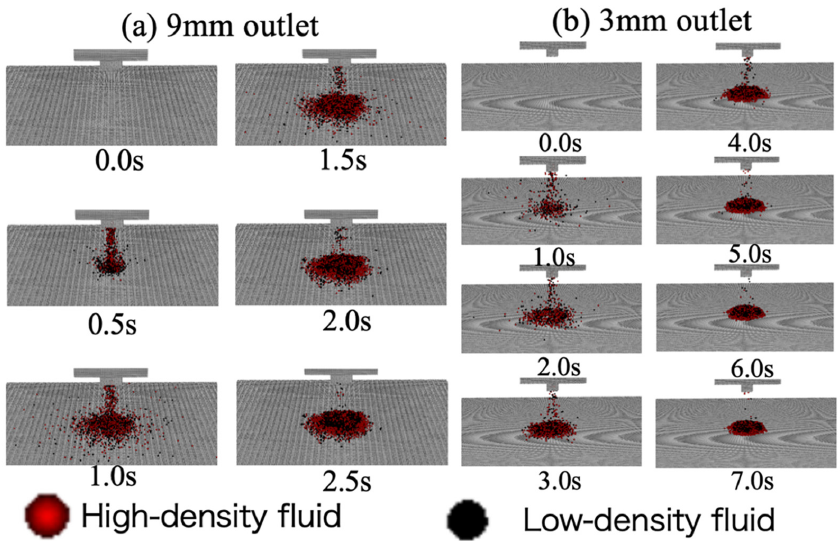
Figure 12. Snapshots of the spreading behaviour with different outlets in the case of the reverse density stratification ( a ) 9 mm outlet, ( b ) 3 mm outlet.